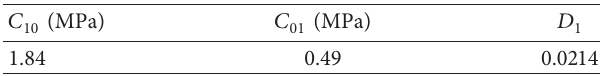
Table 2: Nitrile rubber